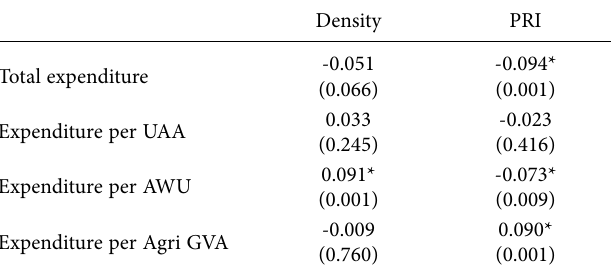
Table 6. Pearson correlation coefficients between RDP expenditure and different indicators of rurality (p-values in